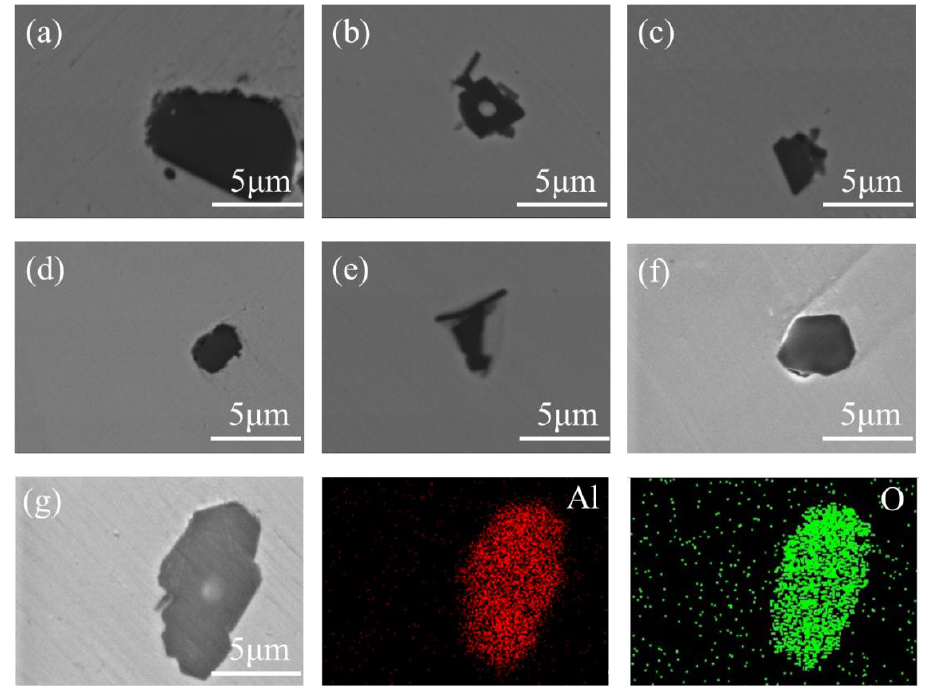
Figure 1. SEM/EDS image of alumina inclusions in the sample S1. ( a – g ) SEM image of alumina inclusions in the sample S1.